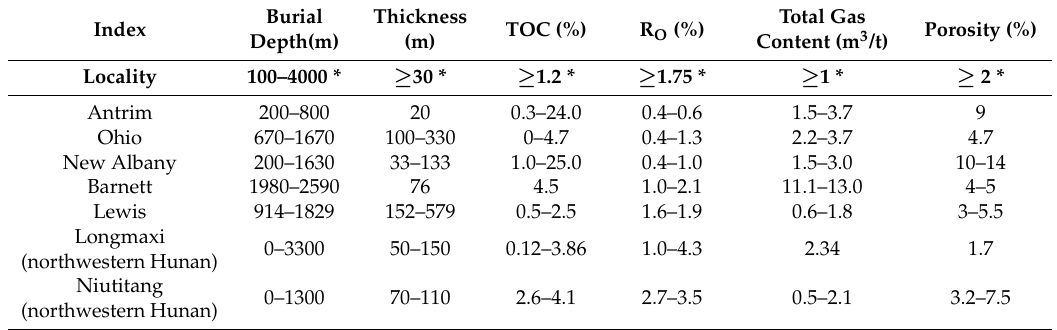
Table 4. Comparison of the geological parameters of Niutitang Formation shale in northwestern Hunan with that of five main shale gas basins in the United States (Modified from [4,25,43]).